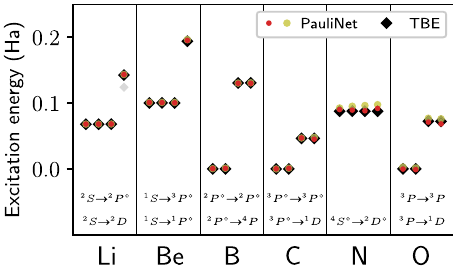
Fig. 1 | Deep VMC obtains highly accurate excited states for single elements. PauliNet results for the excitation energies (with (red) and without (yellow) var- iance matching (see the “ Methods ” section for details)) are compared to the the- oretical best estimates (TBE) taken from the NIST database 36 . Multiple PauliNet ansatzes with identical energies correspond to orthogonal degenerate states. For the TBE we have depicted four excitations per atom, taking account of the degeneracies.Forallatoms,we fi ndthe fi rstexcitedstatewithhighaccuracy.ForB, C,andOthegroundstateisthreefolddegenerate.Forthesesystemswechooseone of the three states to compute excitation energies, resulting in transitions with a relative energyof zero.ForLiand Beafurtherexcitationenergyisfound.Whilewe obtain the second excited state for Be, in Li we miss out intermediate states and instead fi ndthetransitionfromthegroundstatetothe 2 Dstate.Thiscanberelated to the generic CASSCF initialization of the ansatzes (see the “ Methods ” section for details). (The numerical data can be found in Supplementary Table II; source data are provided as a Source Data fi